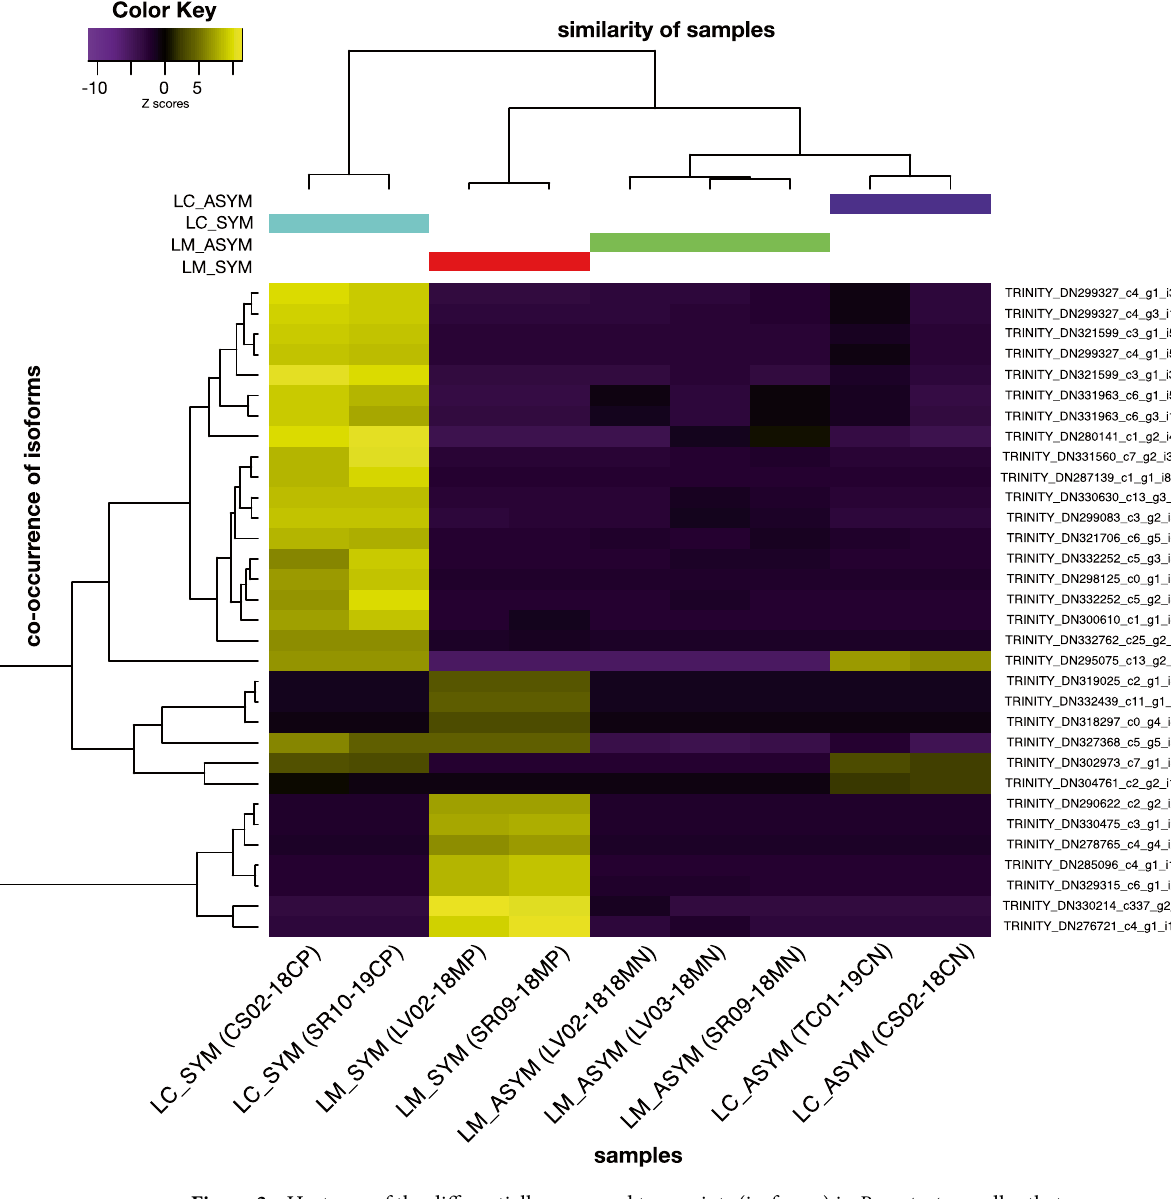
Figure 3. Heatmap of the differentially expressed transcripts (isoforms) in P. contorta needles that were asymptomatic (ASYM) and symptomatic (SYM) of Lophodermella concolor (LC) or L. montivaga (LM) based on counts per million (CPM) reads. Trinity transcripts shown are the top 10 differentially expressed features (p-value < 0.001, fold change ≥ 2) within each of the four pairwise comparisons. Similar colors at tree tips represent replicate samples within each of the following treatments: LC_ASYM (purple), LC_SYM (blue), LM_ ASYM (green), and LM_SYM